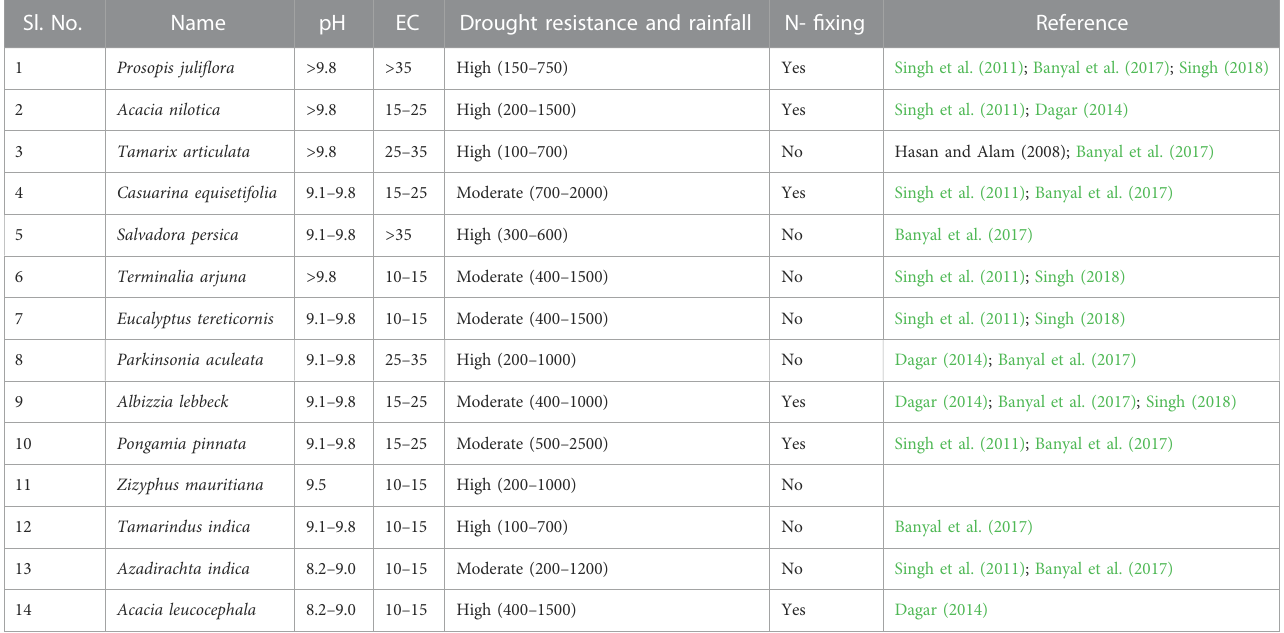
TABLE 4 Ameliorative effect of plantation trees ( > 10 years) on salinity-affected soils in India. Sl.